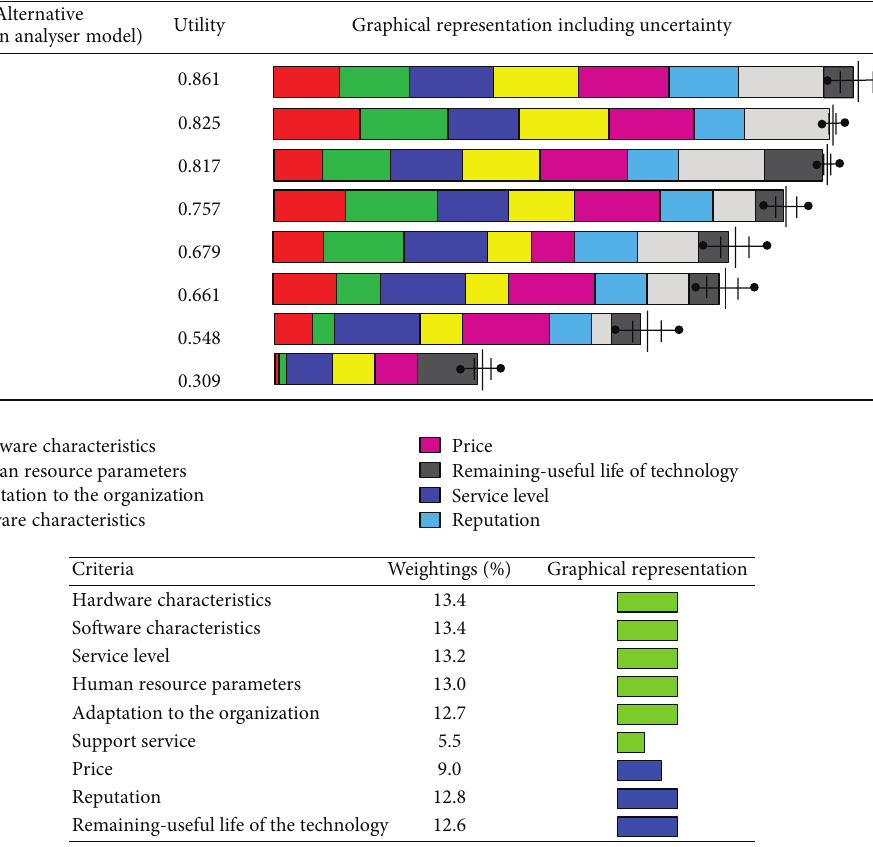
Figure 4: Results of the sensitivity analysis when the weighting of price is decreased.